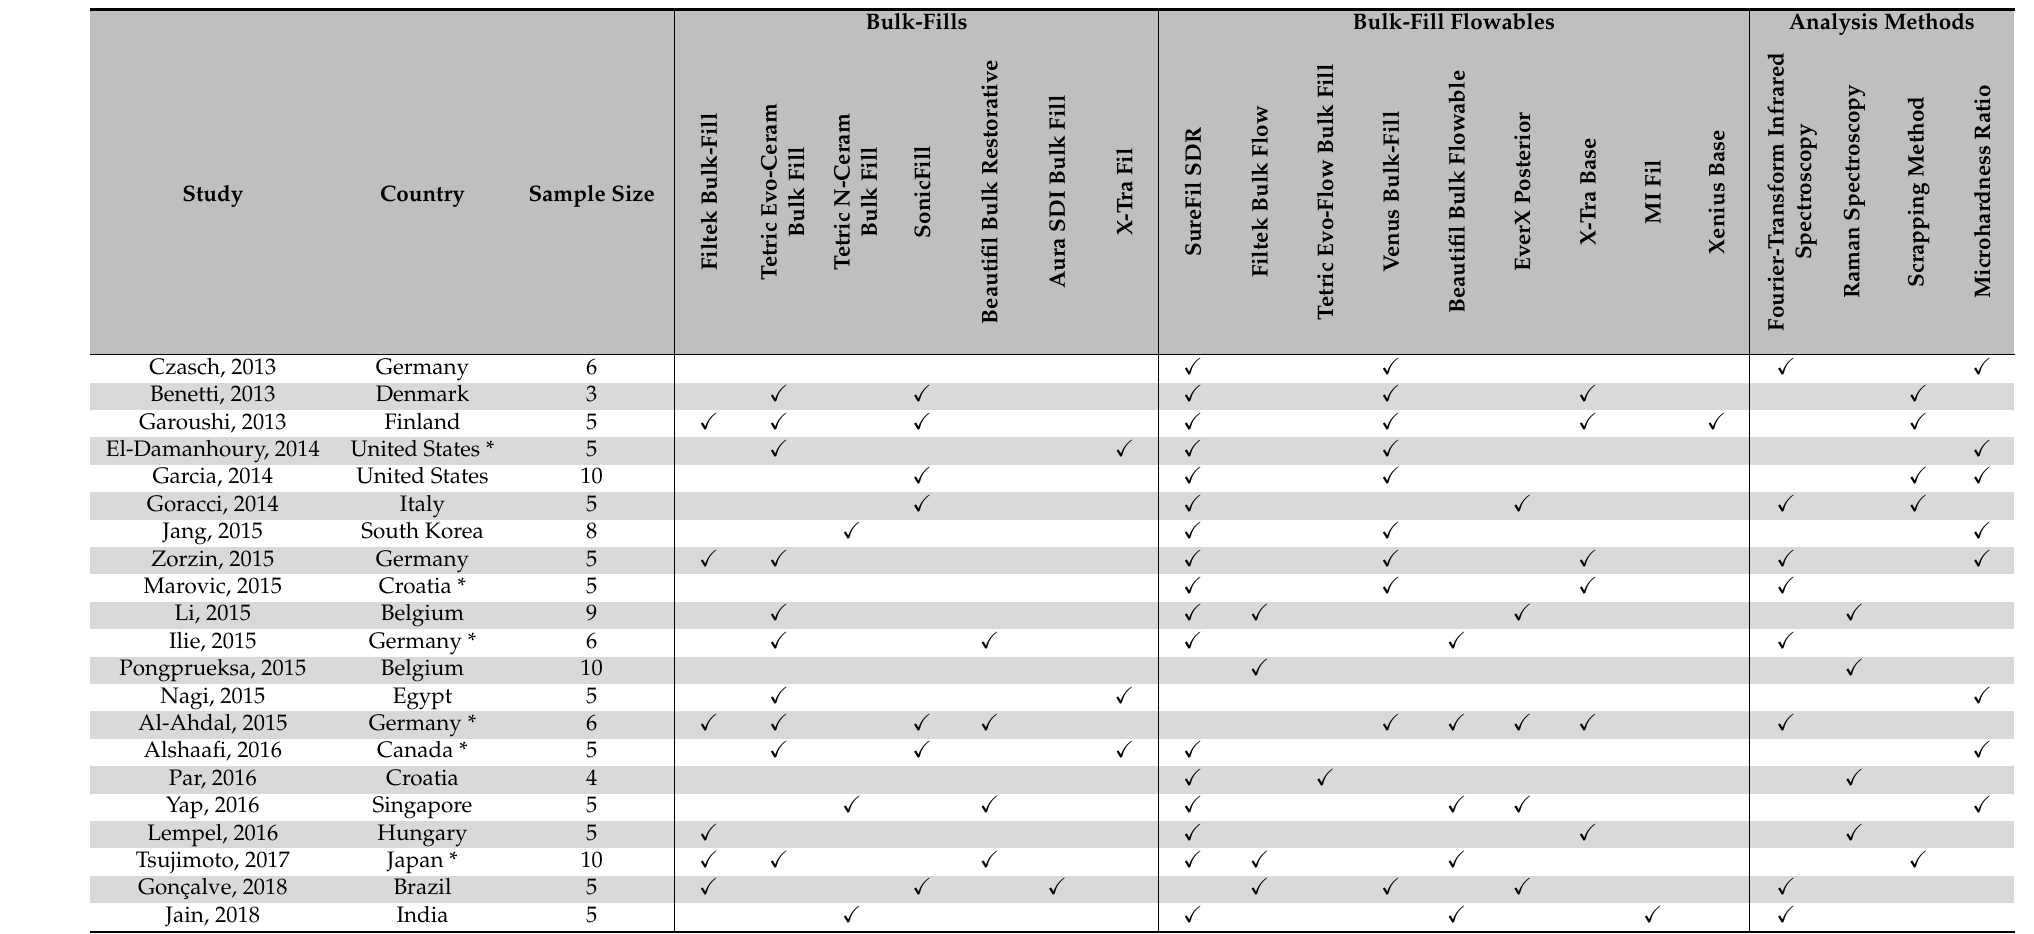
Table 1. Summary of the eligible studies characteristics. Bulk-Fills Bulk-Fill Flowables Analysis